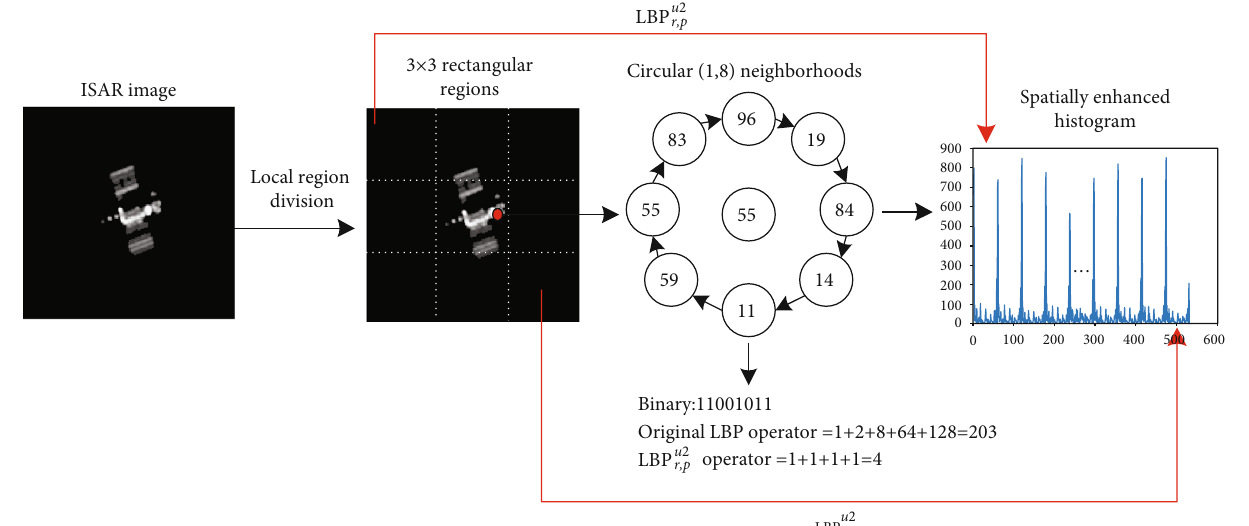
Figure 11: LBP feature extraction process of the ISAR image.